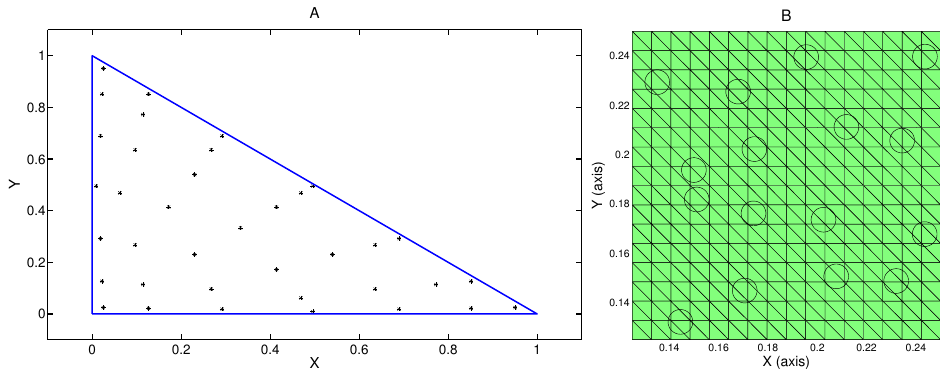
functions in the (cid:15)